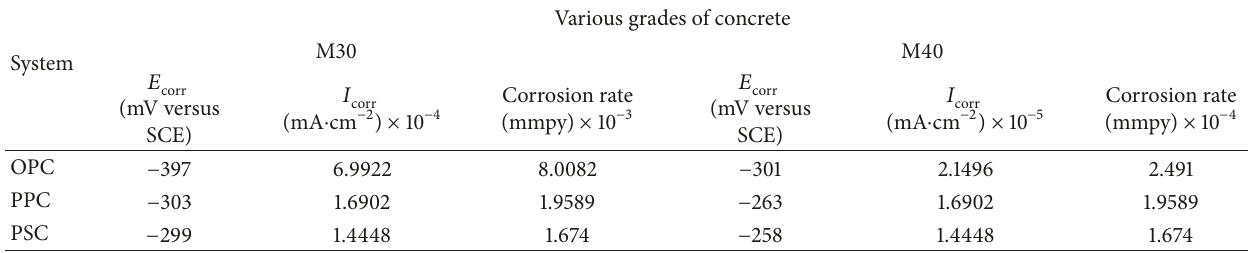
Table 6: Potentiodynamic polarization parameters for the corrosion of rebar embedded in OPC, PPC, and PSC M40 grade concrete (90-day cured